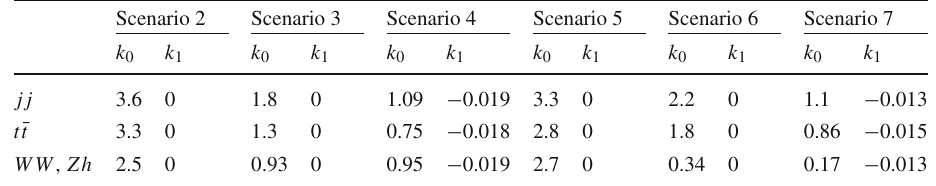
Table 14 Numerical